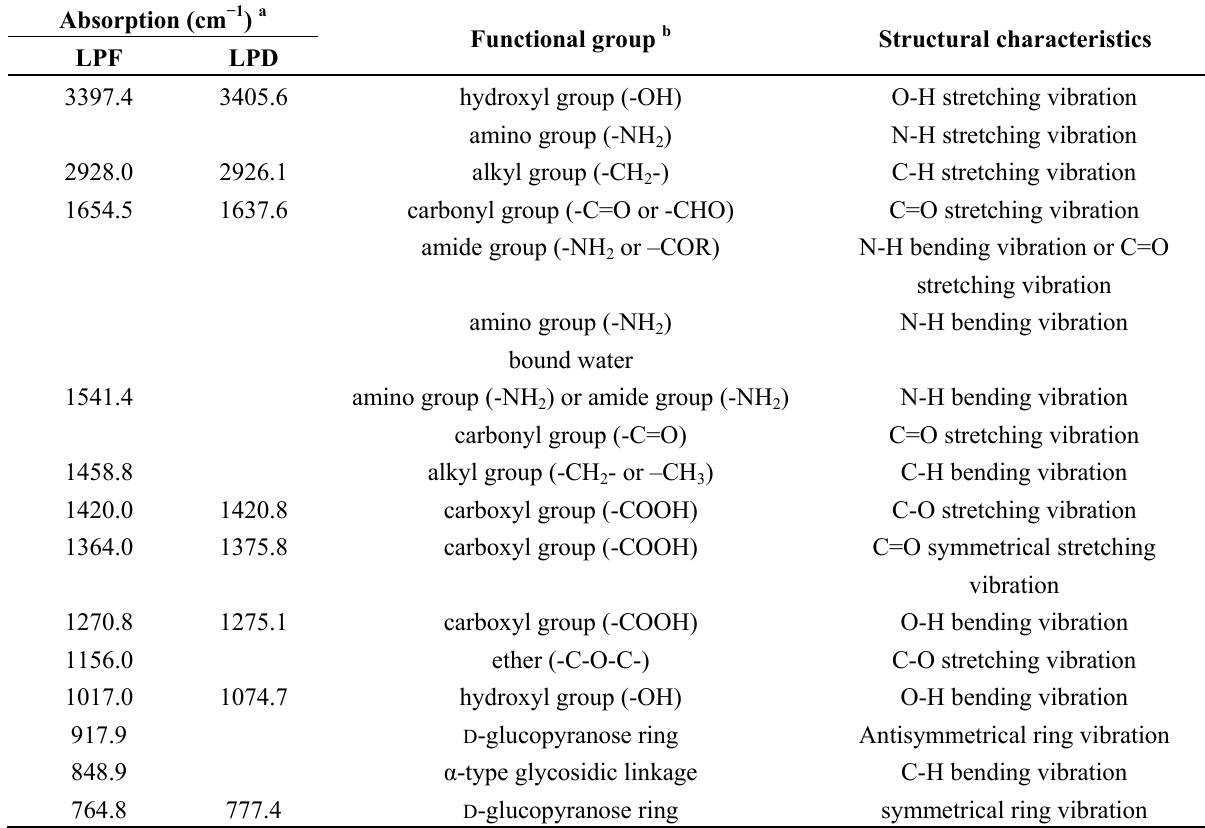
Table 2. FTIR spectra of litchi polysaccharides LPF and